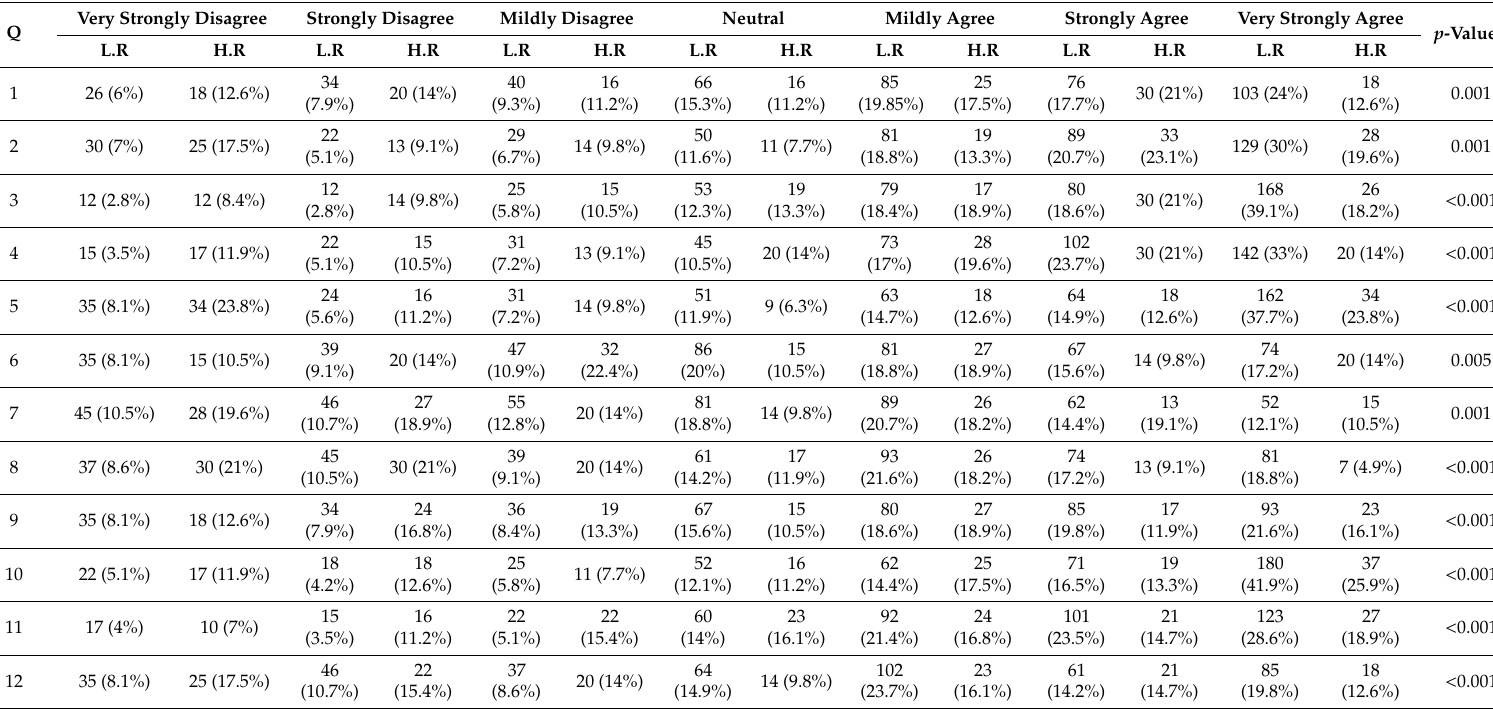
Table A4. Frequency of the Multidimensional Scale of Perceived Social Support (MSPSS) in low-risk (L.R.) and high-risk (H.R.) groups (Cut-o ff = 48).